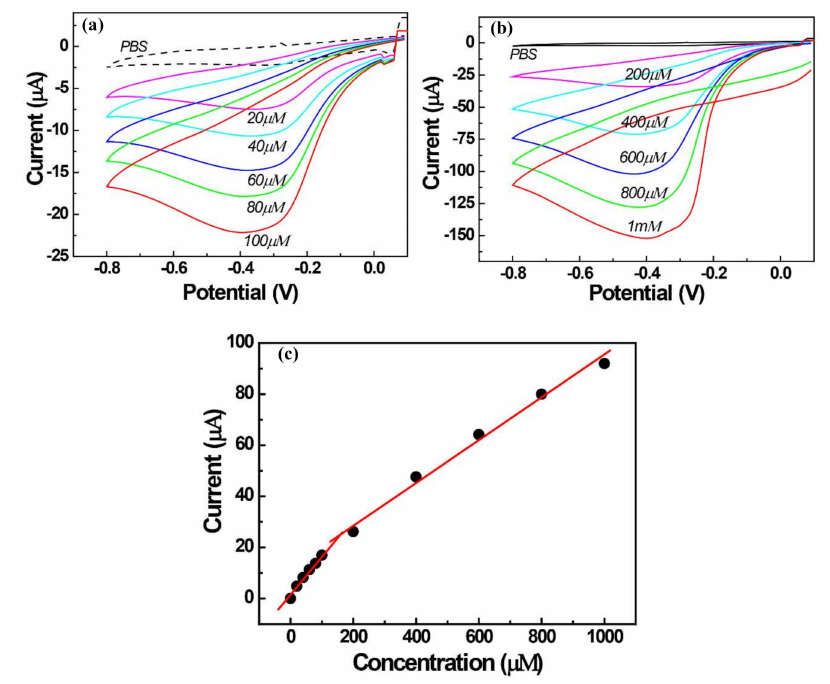
Figure 5. Cyclic voltammograms of 0.5 wt / vol % AgNPs / PEI-decorated GCE for H 2 O 2 concentrations of ( a ) 20–100 µ M, ( b ) 200–1000 µ M, and ( c ) the corresponding calibration